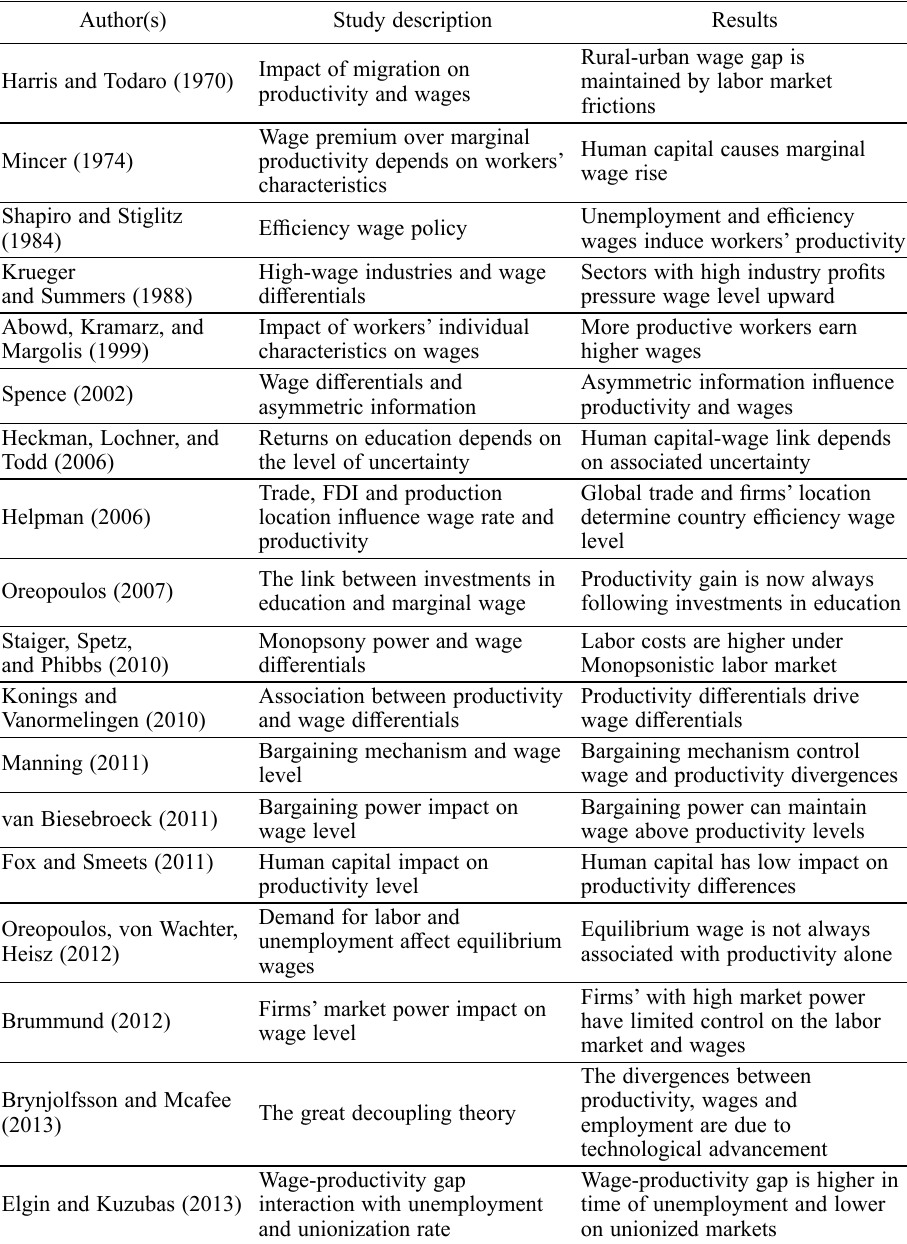
Table 1. Overview on productivity-wage-employment link